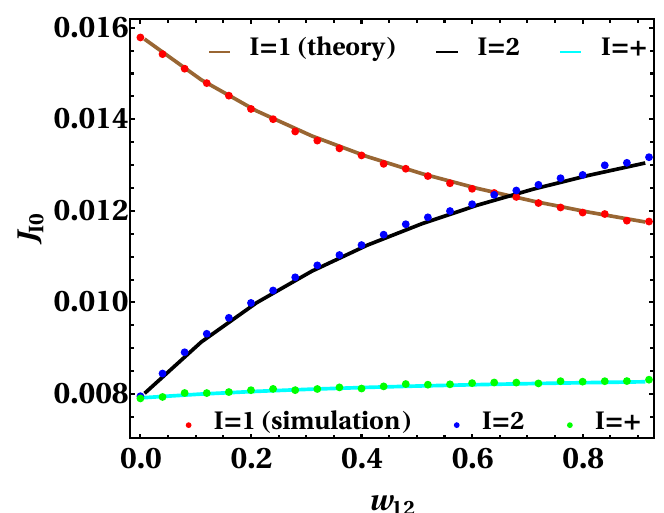
Figure 5: The figure shows comparison of drift currents J between theory (solid I 0 lines) and Monte Carlo simulations (points) by changing flip rate w . The 12 nonlinear monotonic decrease and increase in J and J respectively are simi- 10 20 lar in nature to the effect of w on the species densities (Fig. 3). The impu- 12 rity drift current increases slowly with increasing w . The parameters used are 12 = 0.3, p = 1.0, ε = 0.1, w = 0.6, ρ = 0.2, ρ = 0.2. The ensem- L = 10 3 , p + 1 2 21 0 ble average is done over 10 5